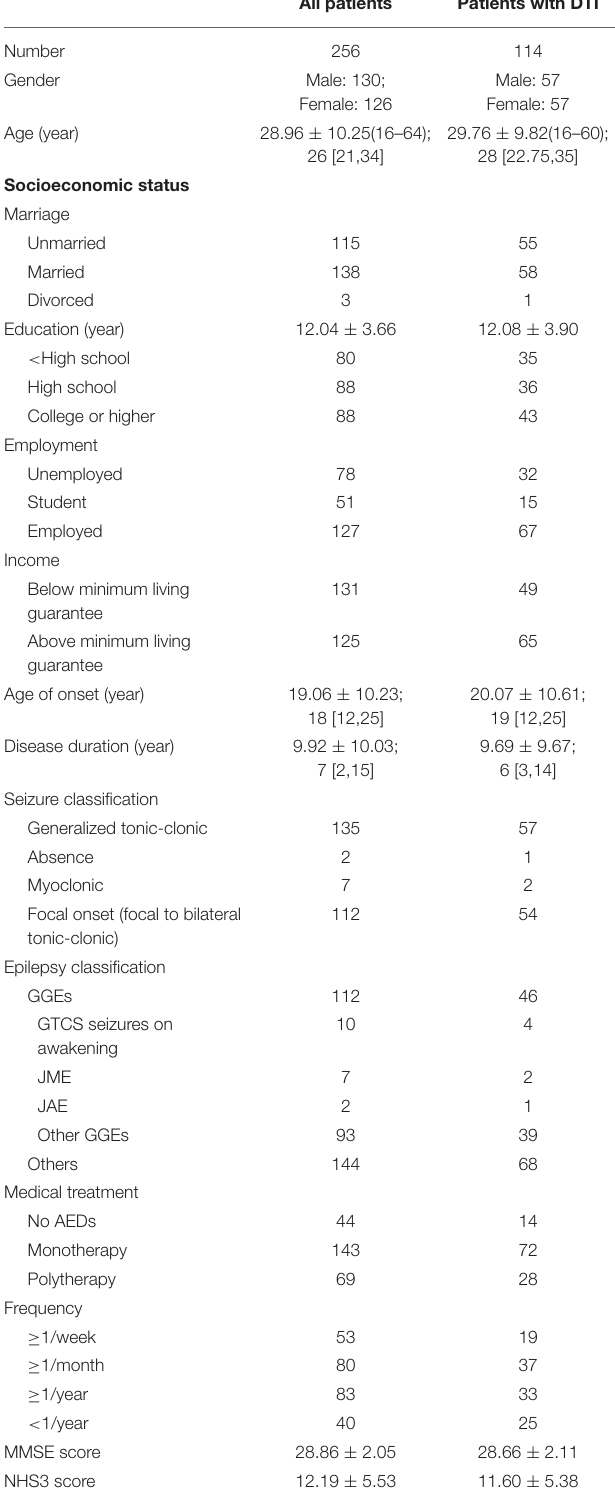
TABLE 1 | Demographic and disease characteristics of epilepsy patients. TABLE 2 | The percentage of different answers to each question of stigma All patients